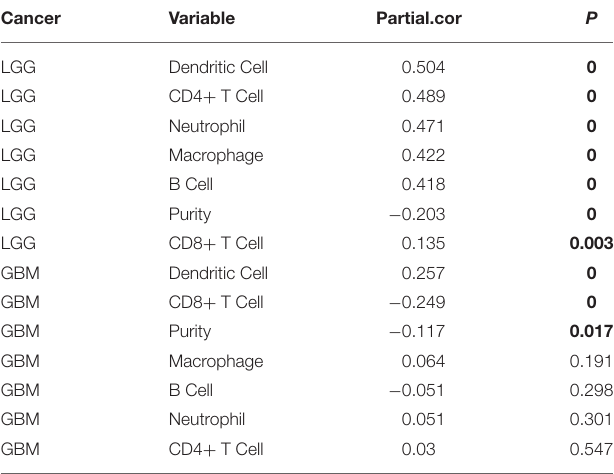
TABLE 1 | Association between HIST1H2BK expression and immune infiltration in glioma (partial Spearman correlation).